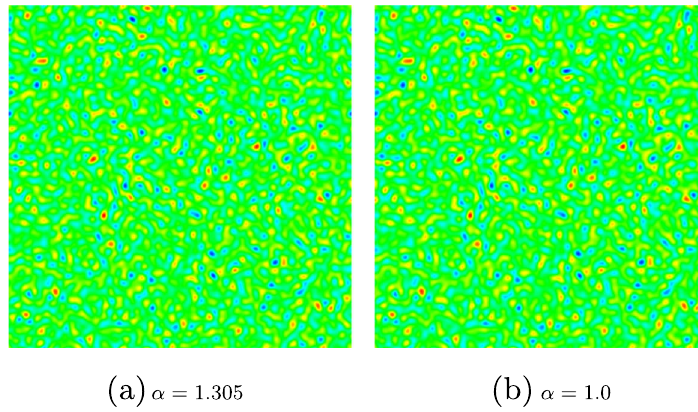
Fig. 10 Snapshots of the spinodal decomposition process, τ = 0.3 , T r = 0.8 , t = 80